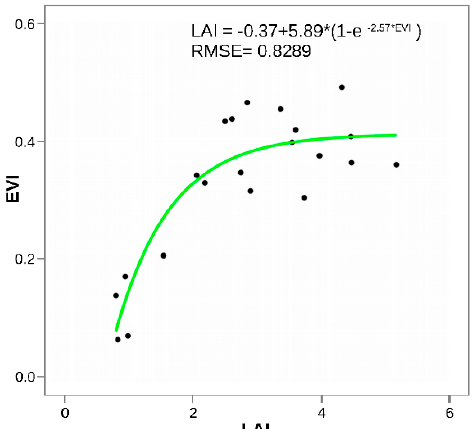
Figure 4. Empirical relationship between the Enhanced Vegetation Index (EVI) and in situ measurements of leaf area index (LAI) of N. pumilio stands.